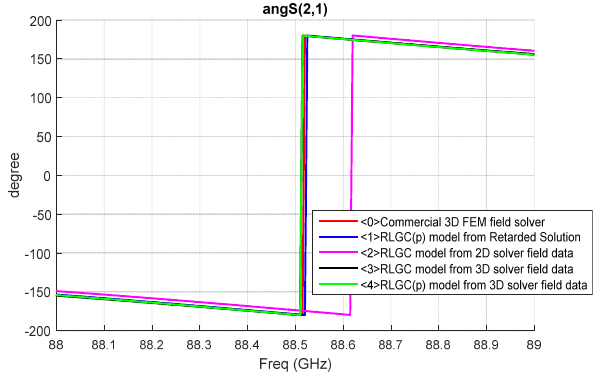
Figure 19: Phase of S12 from 88 GHz to 89